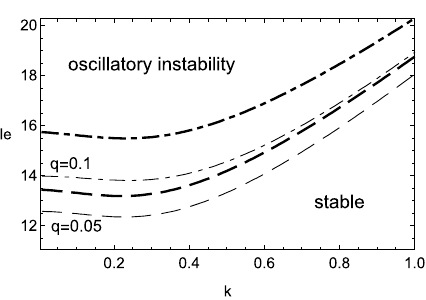
Figure 3. Stability boundary of oscillatory instability for several values of heat release, q (dashed) and 0.1 (dot-dashed), with β